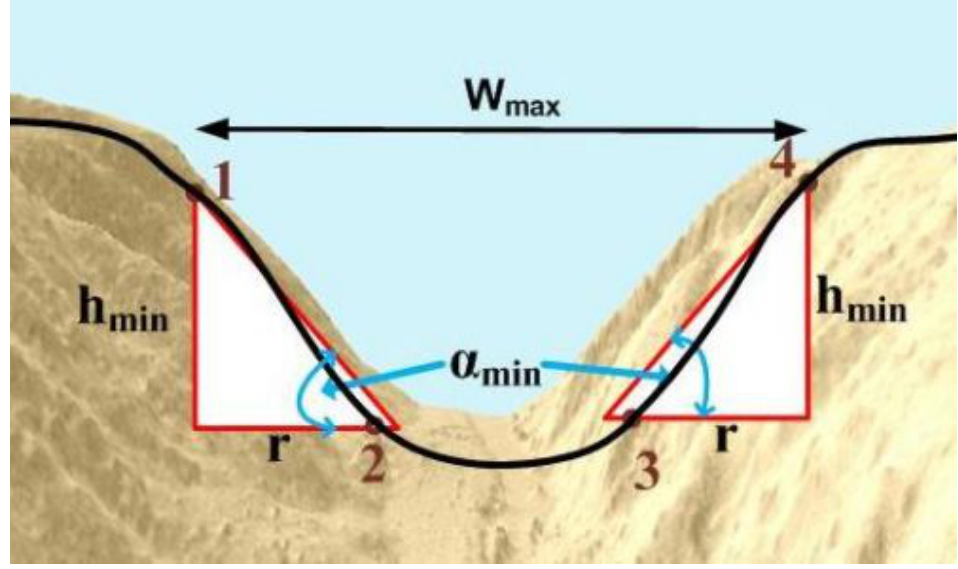
Figure 3. Geometric relationships between four characteristic points (1, 2, 3 and 4) defined by the parameters of the maximal width W inclination angle α min